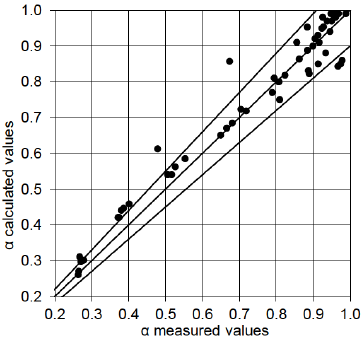
Figure 15: Measured and calculated normalincidence sound absorp- tion coeflcient comparison (no air gap)